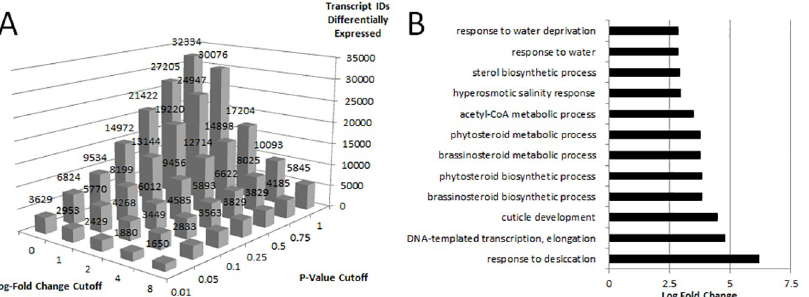
Fig 1. Number of differentially expressedgenes identified by RNAseq analysis. A) the number of transcripts differentially expressedin RNAlater comparedto liquidN 2 shown by log-foldchange(base two) and p-valuecutoffs and B) the log fold enrichment of the GO terms for biologicalprocesses enriched for the 5770 transcript IDs differentiallyexpressedat log-foldchange ± 1 (p (cid:20) 0.05). All reportedGO terms are significantat a p-valueof 0.05 or below.